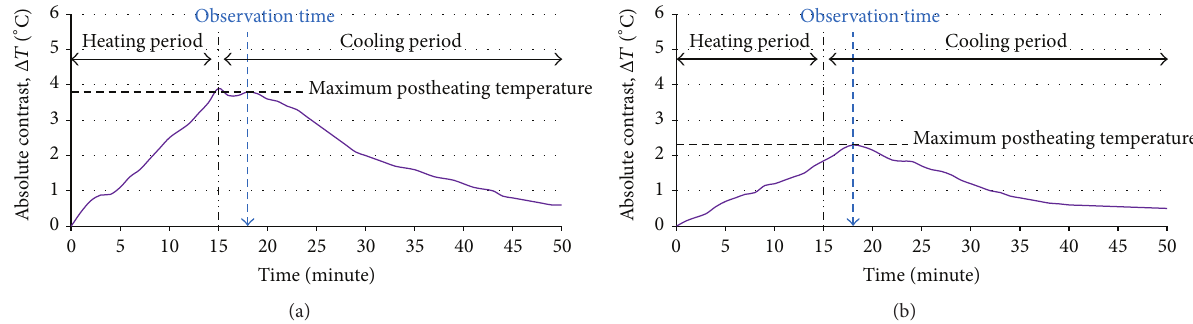
Figure 11: Determination of observation time for the typical shapes of variations in the absolute contrast during the cooling